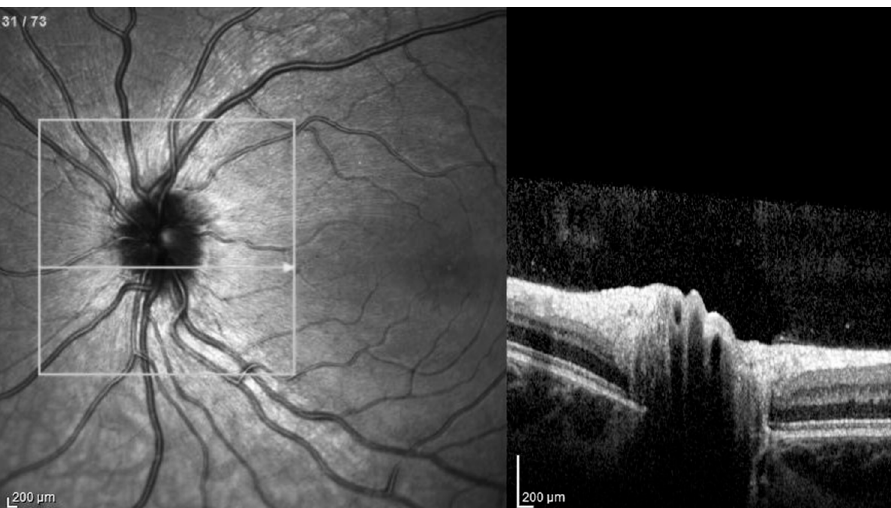
Figure 3. Optical coherence tomography: Large optic disc drusen, visible as a hypo-reflective structures with a total or partial hyperreflective margin, as described by the Optic Disc Drusen Studies (ODDS) Consortium. The hyperreflective margin is often more evident superiorly and can be difficult to detect.